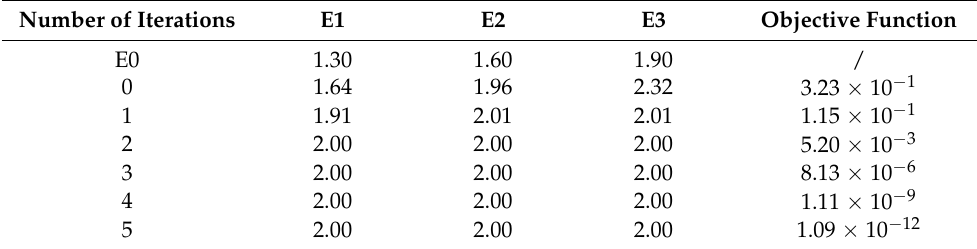
Table 7. Calculation results with centralized measuring points at the support.